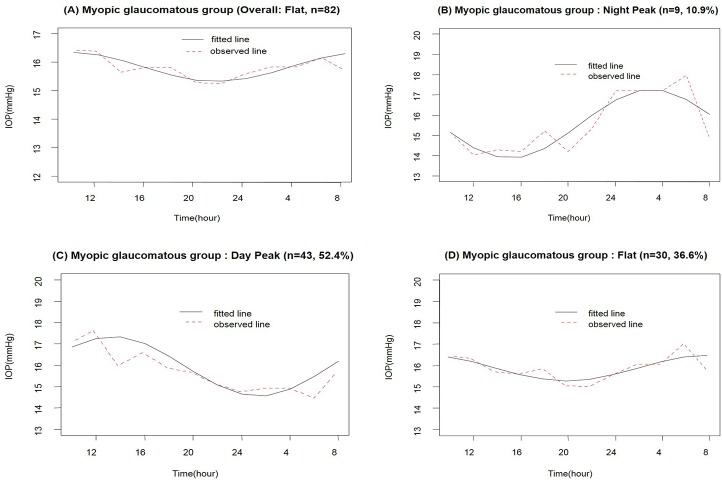
Average 24-h rhythms of habitual-position IOP in all patients (A) and in three subgroups of patients (B, C, and D) based on the cosinor model in the myopic glaucomatous group.